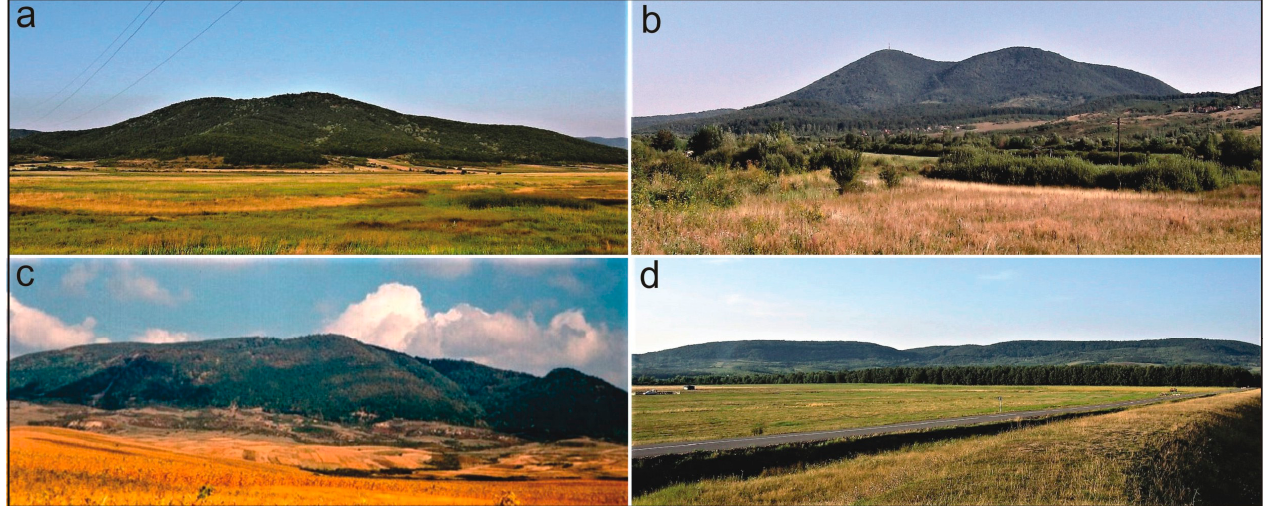
Figure 3. The landforms of some extrusive domes from Oa ș Mountains Ple ş cu ţ a rounded shape , dome with low angle slopes ( a ); Jeleznic conical steep slopes shape dome ( b ); Ora ş u Nou flat topped large-sized lava-dome ( c ); Hatu Lung dome-coulée with flat top elongated shape ( d ). (Photos: Mari- nel Kovacs— a , b , d ; Alexandrina Fülöp— c ).